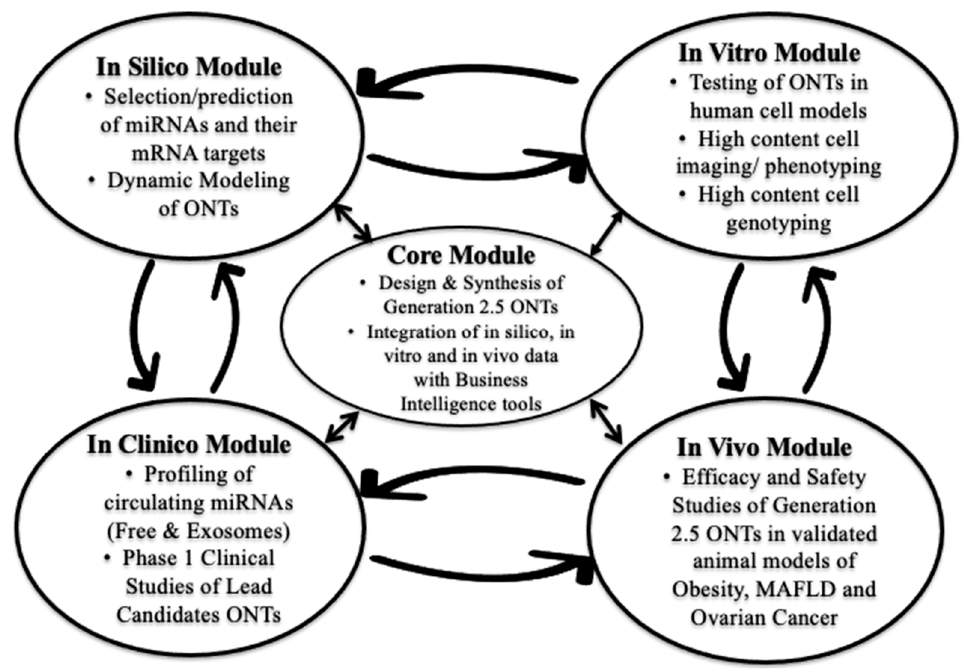
Figure 1. AptamiR Therapeutics’ Modular Parallel and Iterative Strategy of Drug Discovery and Development. and